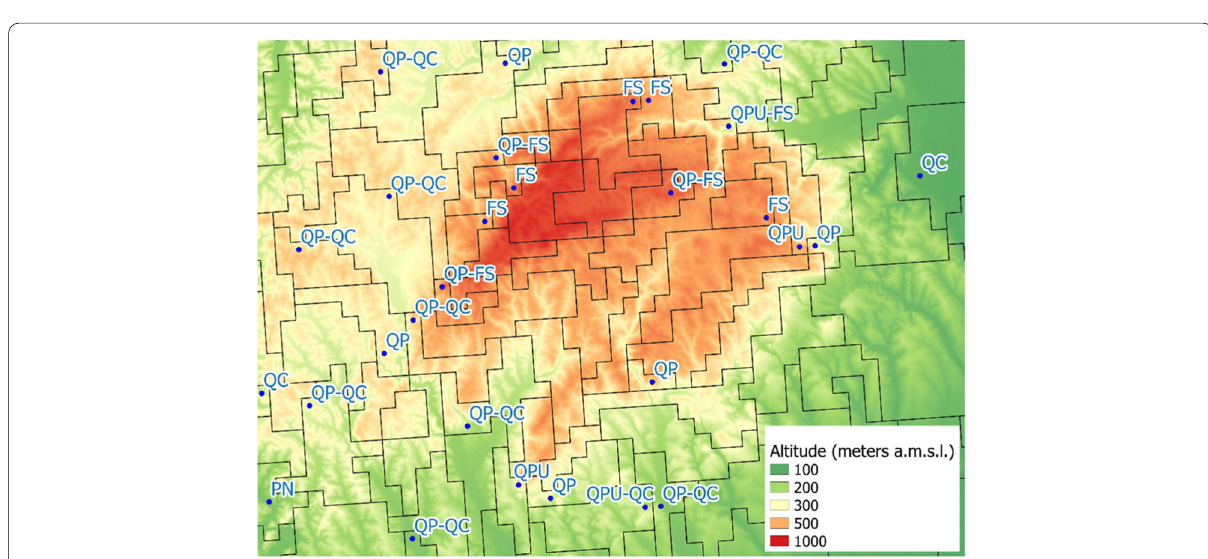
Fig. 6 Example of the segmentation map based on 36 bioclimatic variables for the reference period 1961–1990. Points within the segments indicate the rasterized species occurrences. The background is a digital elevation model (source: Institute of Geodesy Cartography and Remote Sensing (IGCRS)) with a resolution of 20 m. Labels are abbreviations for each tree species and their combinations (Table 1 and Table